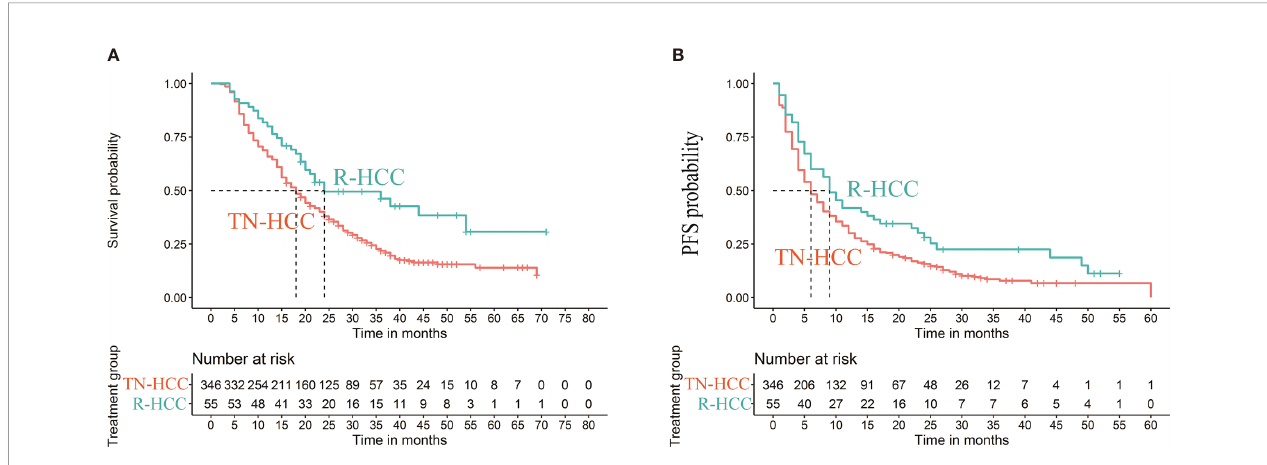
FIGURE 2 | Kaplan-Meier curves of cumulative survival (A) and progression-free survival (PFS) (B) in patients with recurrent HCC after liver resection and treatment- naïve HCC before propensity score matching.